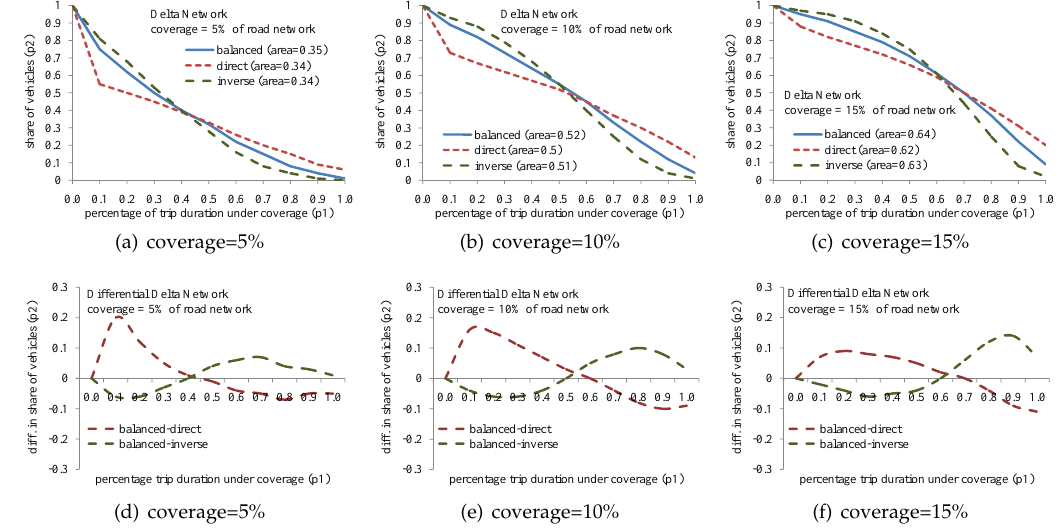
Figure 12. ( a – c ) Present the Delta Network in a single plot for the three proposed strategies: balanced (blue), direct (red), and inverse (green). ( d – f ) Present the Differential Delta Network. In these figures, the red curve indicates the value “ balanced minus direct ”, while the green curve shows “ balanced minus inverse ”. Figure 12d–f present the Differential Delta Network of (i) direct compared to balanced , and (ii) inverse compared to balanced . The red curve indicates the value “ balanced minus direct ”, while the green curve plots “ balanced minus inverse ”. All three figures show the same behavior: red curve ( direct ) positive in the first half of the x -axis indicates that balanced provides more red curve ( direct ) negative in the second half of the x -axis indicates that balanced provides less green curve ( inverse ) negative in the first half of the x -axis indicates that balanced provides less connectivity than inverse for low connected vehicles; green curve positive in the first half of the x -axis indicates that balanced provides more connectivity than inverse for highly connected vehicles.